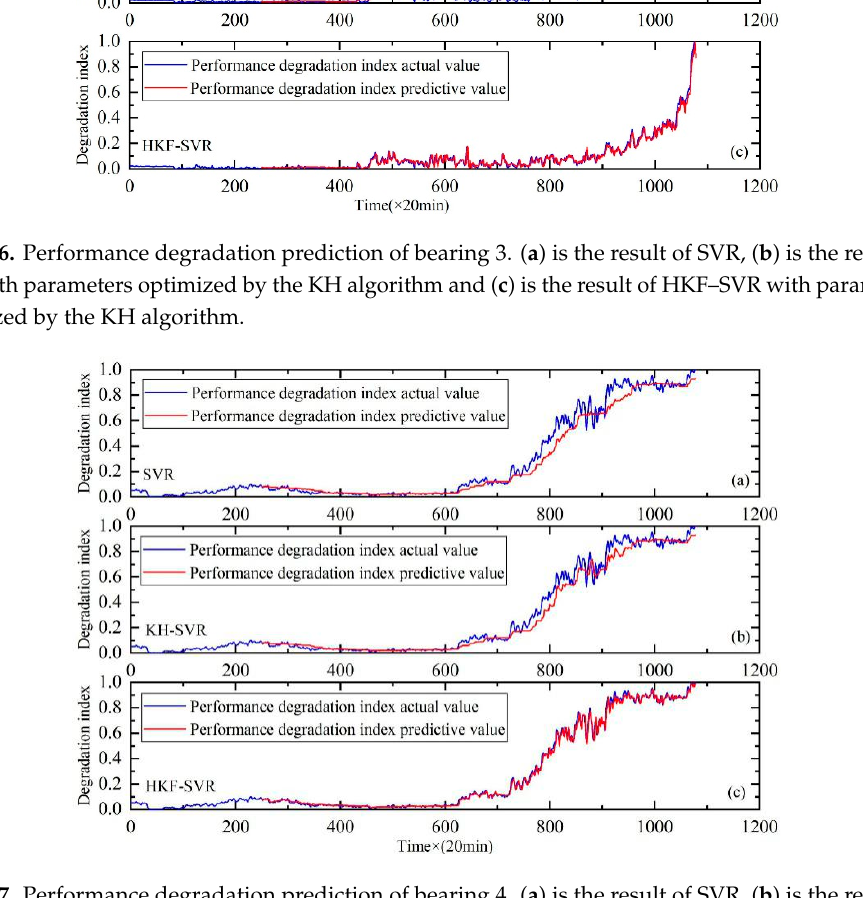
Figure 7. Performance degradation prediction of bearing 4. ( a ) is the result of SVR, ( b ) is the result of SVR with parameters optimized by the KH algorithm and ( c ) is the result of HKF–SVR with parameters optimized by the KH algorithm. Table 4. Prediction errors comparison.